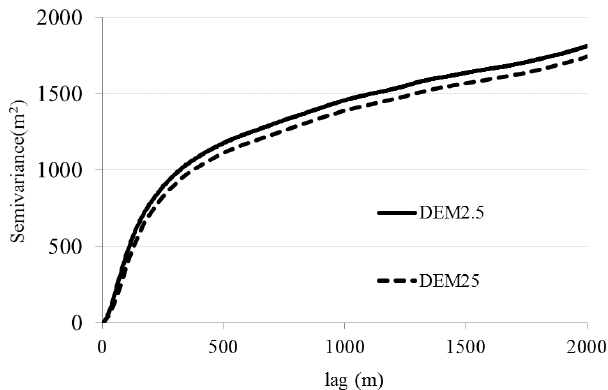
Figure 3. Experimental overall semi-variances at different resolutions.